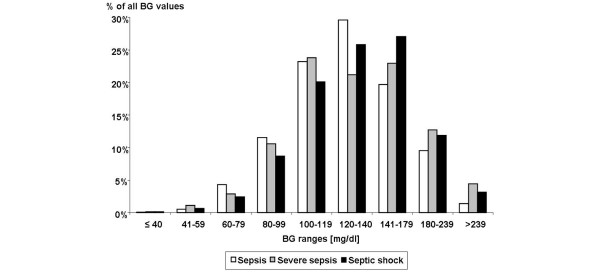
Distribution of blood glucose (BG) values across the different sepsis groups. Each column of the histogram represents the portion of BG values relative to all measured values in the different BG ranges: hypoglycaemia ≤ 40 mg/dl, 41 to 59 mg/dl, 60 to 79 mg/dl; normoglycaemia 80 to 99 mg/dl and 100 to 140 mg/dl; and hyperglycaemia 141 to 179 mg/dl, 180 to 239 mg/dl, ≥ 240 mg/dl.